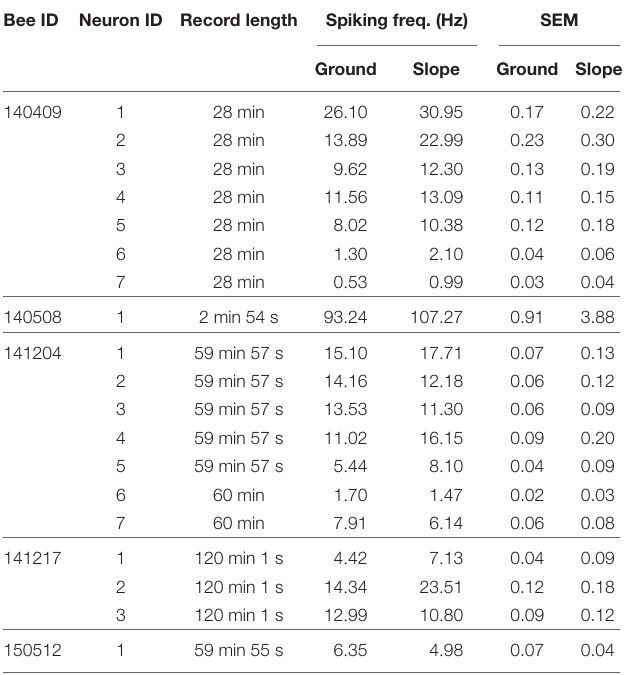
test arena to the first time. This may have led to stronger escape